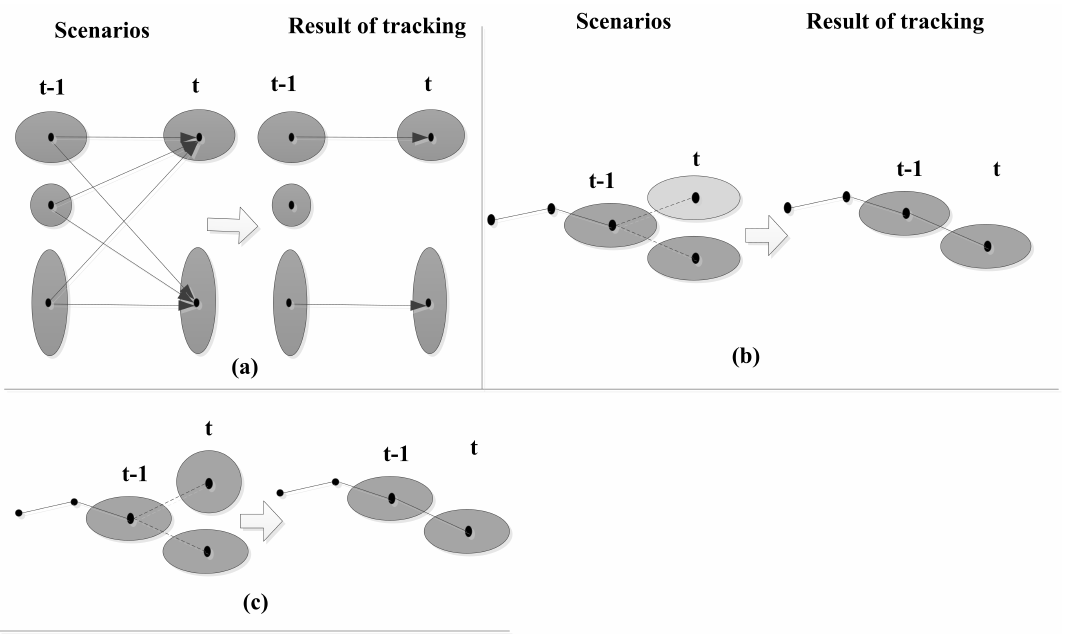
Figure 3. ( a ) The number of storms at t is less than the number of storms at t -1; storms can be tracked based on the distance between centroids and the areas of the storms; ( b ) the reflectivity of the two candidate storms is different; storms can be associated considering the reflectivity distribution of storms; TITANmisses this aspect; ( c ) the eccentricity of the two storms is different; storms’ association can be carried out based on